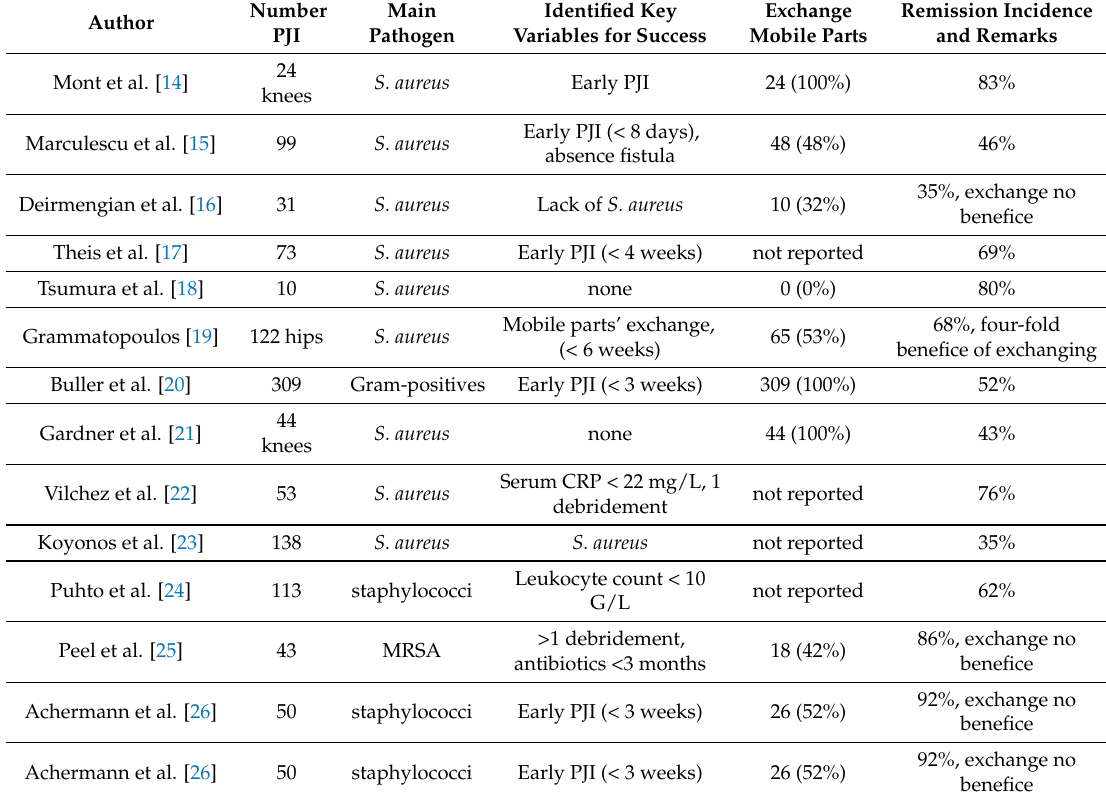
Table 4. Prosthetic joint infections treated with DAIR—selected articles with at least 10 own cases; published since